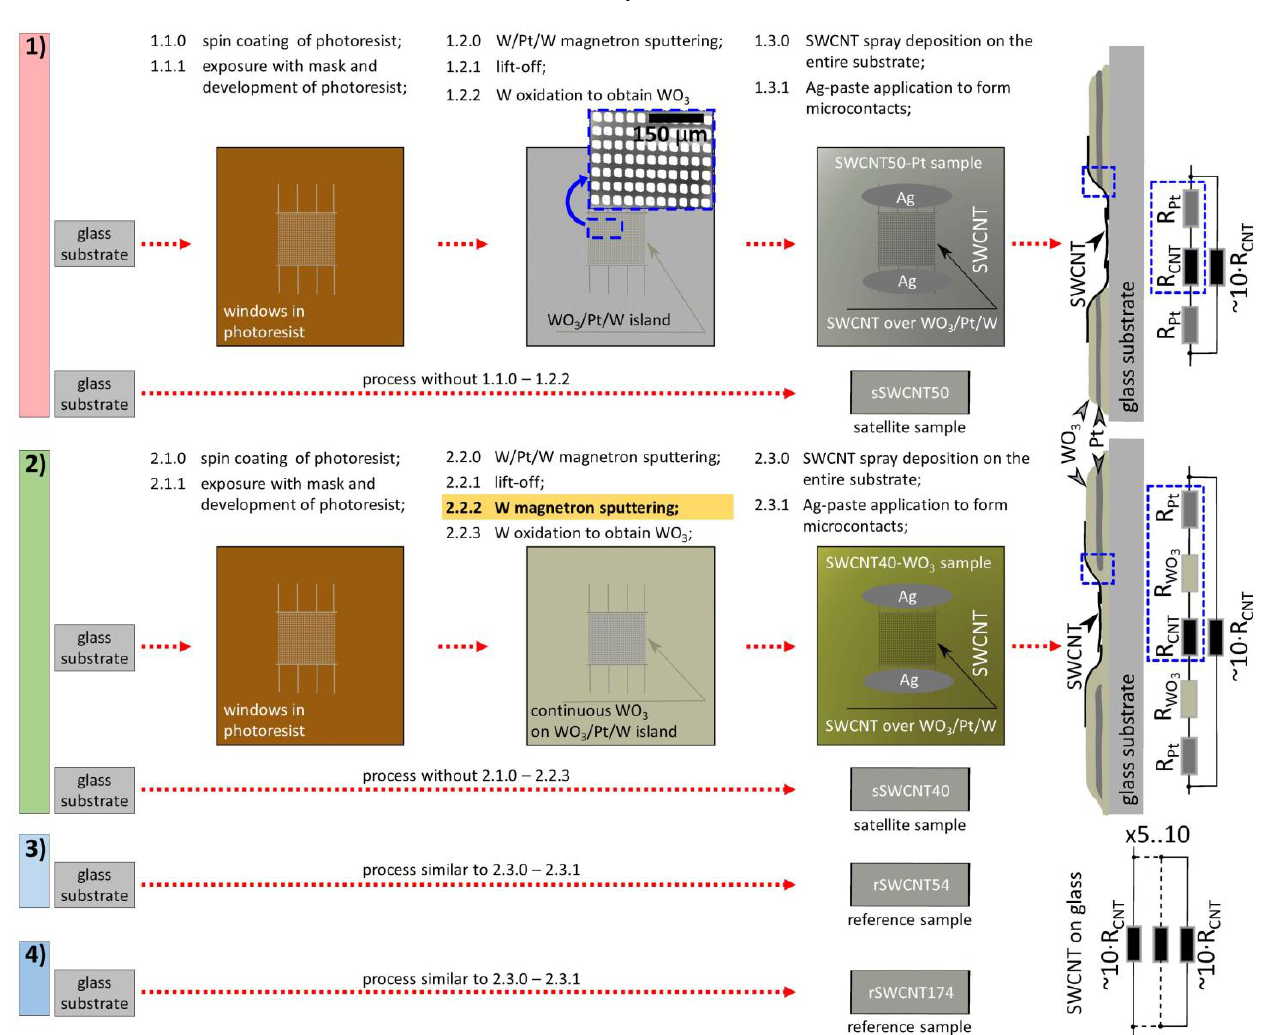
Figure 1. The scheme and technology routs to produce the gas-sensing structures under the study via employing SWCNT layer deposited over WO 3 /Pt/W sublayer formed with lift-off photolithography and over the pure glass substrates. In the right, the cross-section and equivalent circuit schemes of the structures are given.